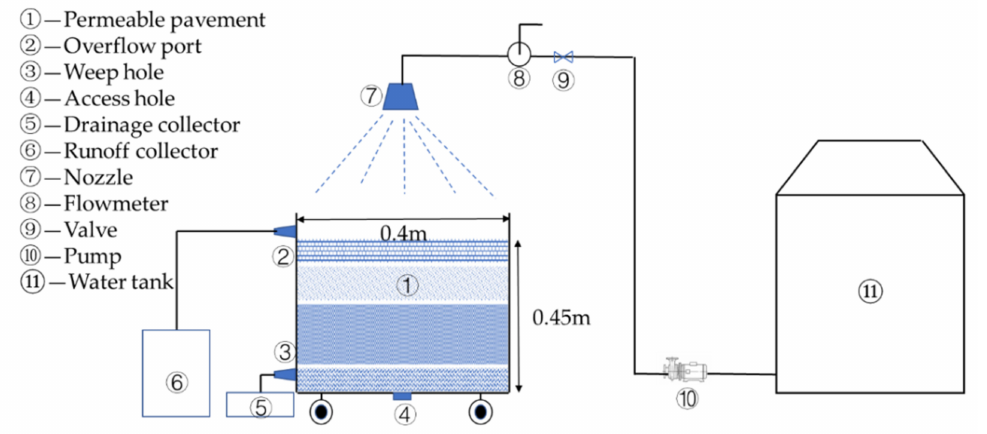
Figure 3. Schematic diagram of the experimental